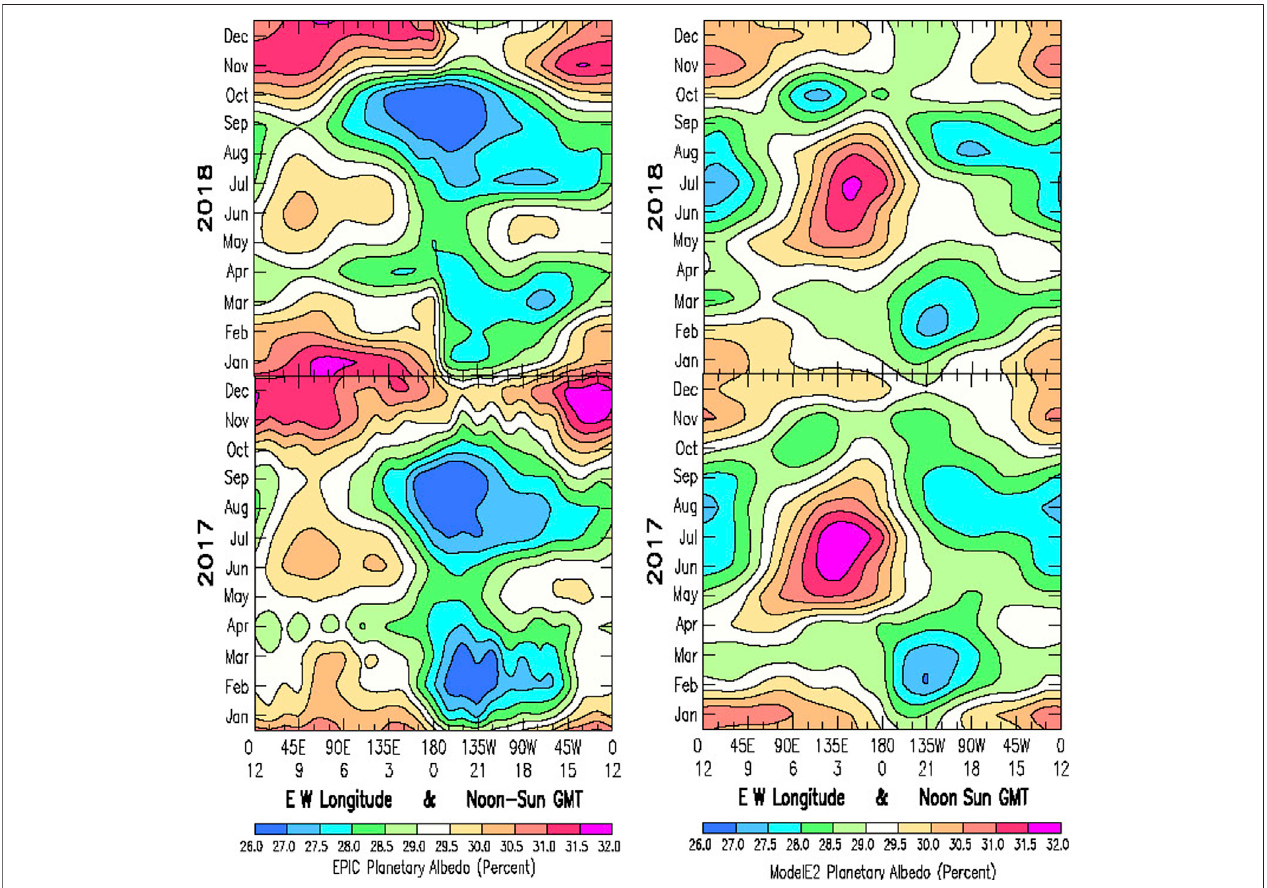
FIGURE3| HovmöllerplotsoftheEPIC (Left) and ModelE2 (Right) planetary albedofor2017and2018forthesamedatapresented in Figure2 .TheY-scalehas timerunningupwardstartingwithJanuary2017atthebottomthroughDecember2018atthetop.TheX-scaleislongituderunningfrom0 ° Elongitudeattheleftand0 ° W longitude at the right. The X-scale references the GMT of the noon-time Sum, starting at GMT = 0 at the Date Line at the center, proceeding westward toward the left as the Earth rotates. The input data for the Hovmöller plots is precisely the same 12 × 24 tables of monthly-mean sunlit hemisphere averages for the 24 uniformly spaced GMT for both EPIC and ModelE2, respectively. In the color bar, magenta identi fi es the highest planetary albedos, deep blue the lowest.